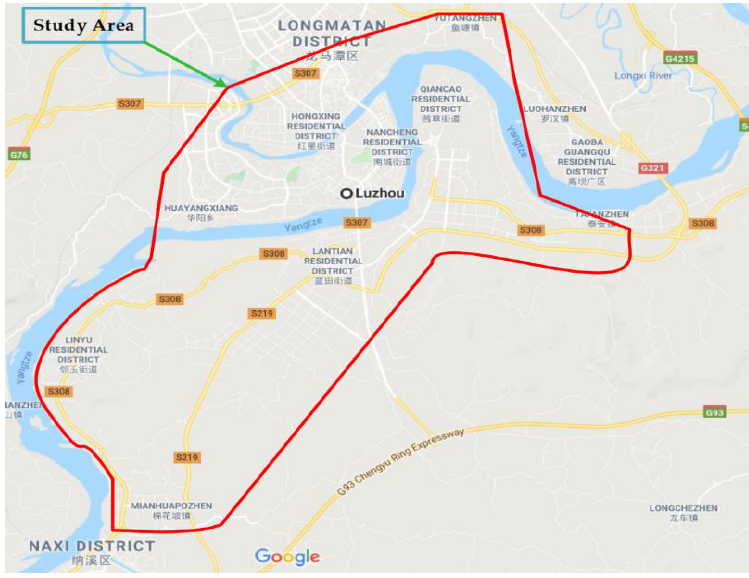
Figure 1. Study area (from Google map) .